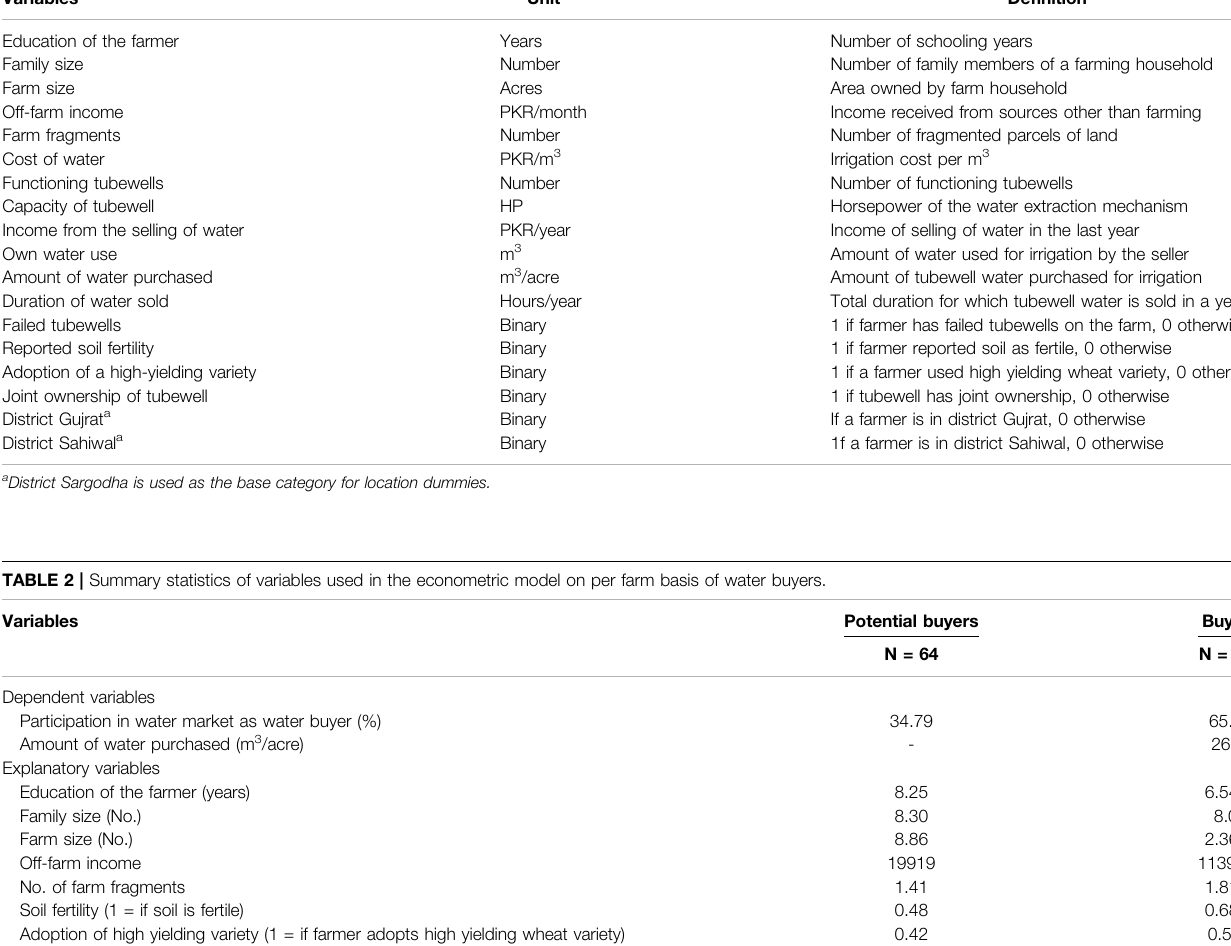
TABLE 1 | De fi nition and measurement of variables used in demand-side and supply-side analysis of water market participation and level of participation. Variables